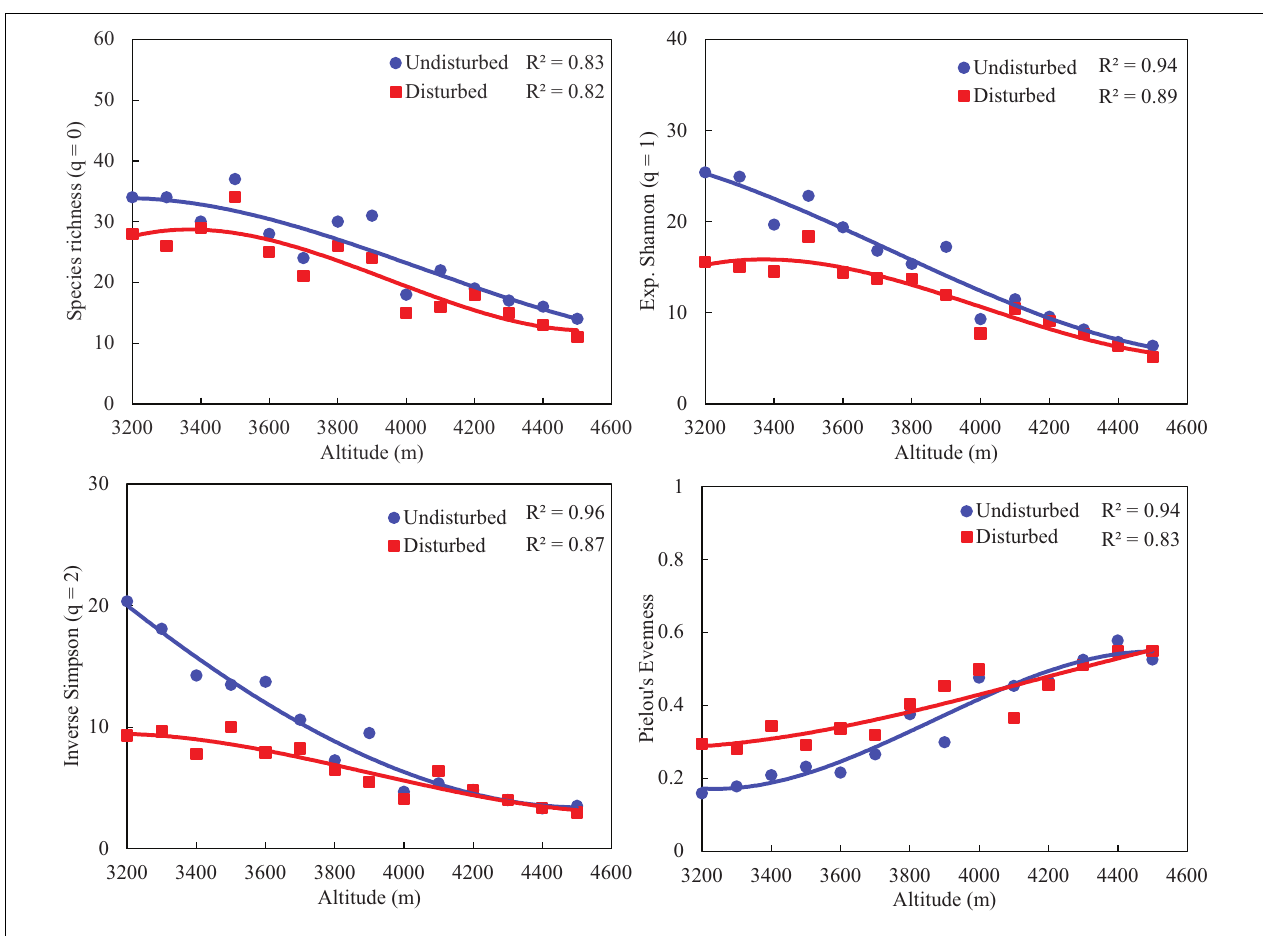
FIGURE 2 | Comparison of diversity (Hill numbers) profiles between disturbed and undisturbed sites along altitude gradients in VoFNP.